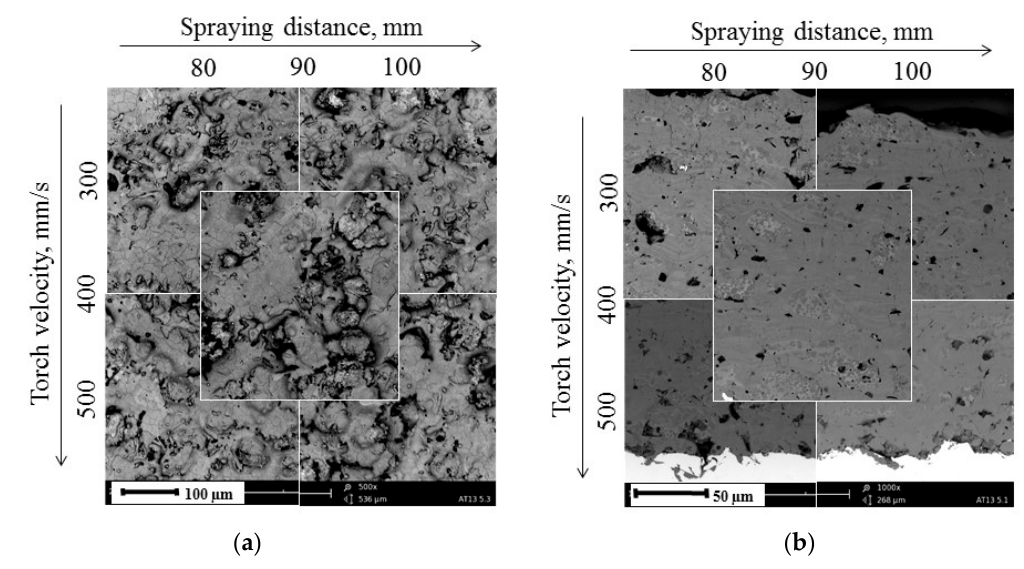
Figure 5. The correlation between spray process parameters and ( a ) free-surface topography and ( b ) microstructure of coatings cross sections.